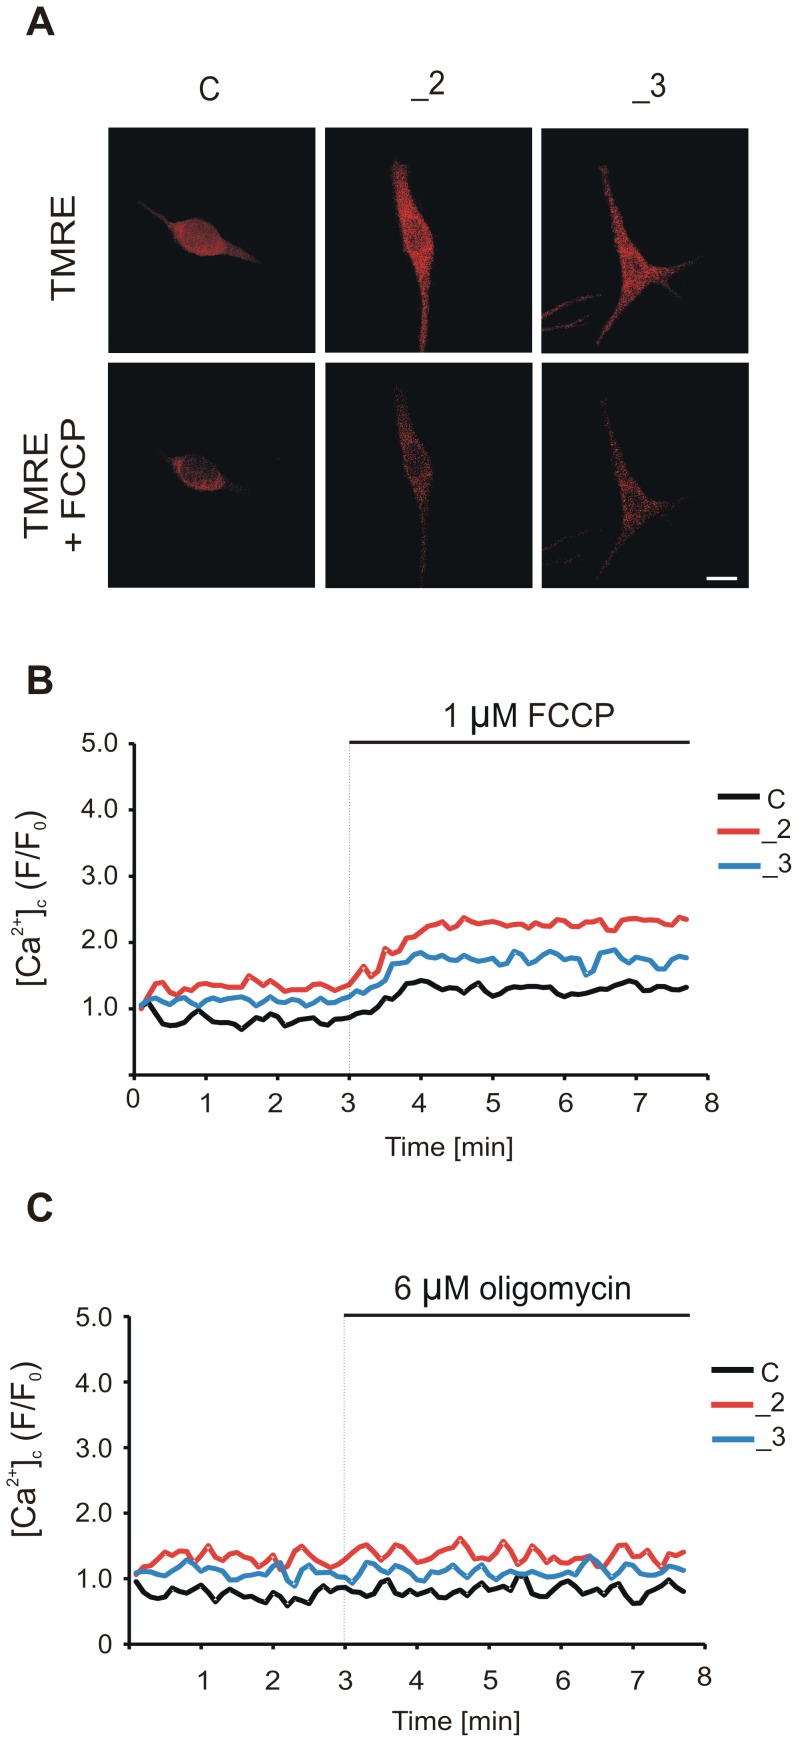
TMRE fluorescence decay upon FCCP treatment and the effect on (Ca2+)c.(A) The representative micrographs showing a decay in TMRE fluorescence in a single cell after 30 s depolarization with 1 µM FCCP. Scale bar 10 µm. (B) Representative traces showing average FCCP-induced Fura-2 fluorescence increase due to release of mitochondrial Ca2+ in n = 15, n = 20, n = 19 cells for C, _2, _3 lines, respectively. (C) Representative traces of average Fura-2 fluorescence showing lack of 6 µM oligomycin effect on (Ca2+)c in 14 cells.